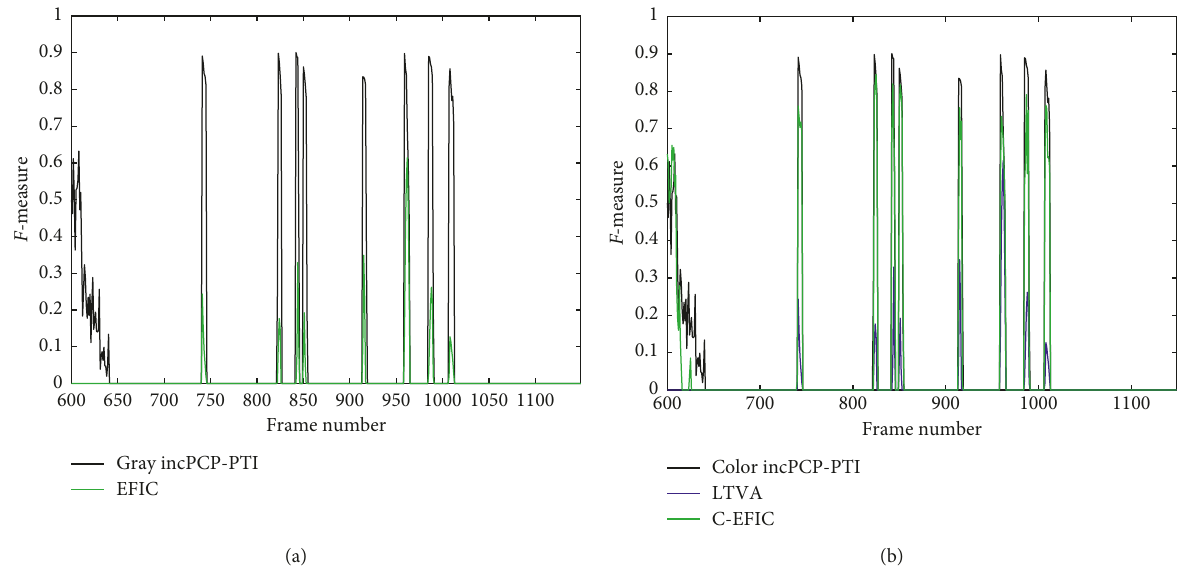
Figure 10: F measure per frame for the CP video for the grayscale-based methods (a) and color methods (b). Note: shown only for available frames (restriction of dataset). This figure is a slightly modified version of ([28], Figure